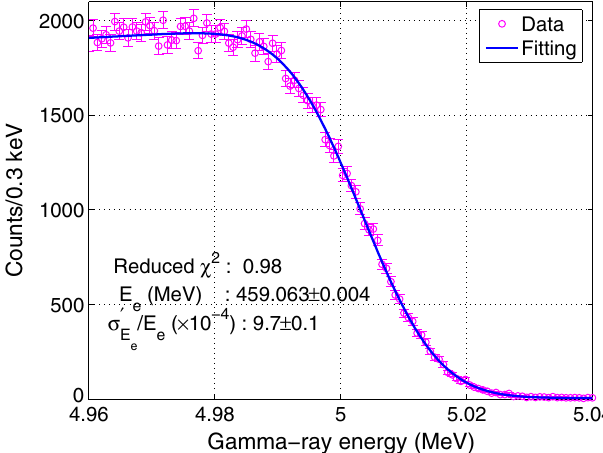
FIG. 11. (Color) An illustration of the fitting on the high energy edge of the measured gamma beam spectrum. The least squares method is used to fit Eq. (16). The goodness of fit is given by the and relative energy reduced (cid:10) 2 . The fit electron beam energy E e =E as well as the fitting errors associated with them spread (cid:5) 0 e E e are also shown in the